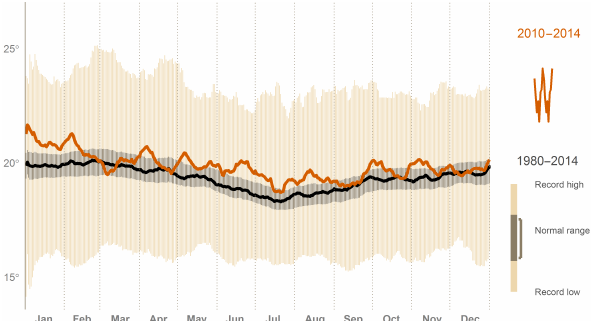
Figure 8. Bogota 10-day moving average of maximum daily tem- perature (2010–2014 versus 1980–2014 values).